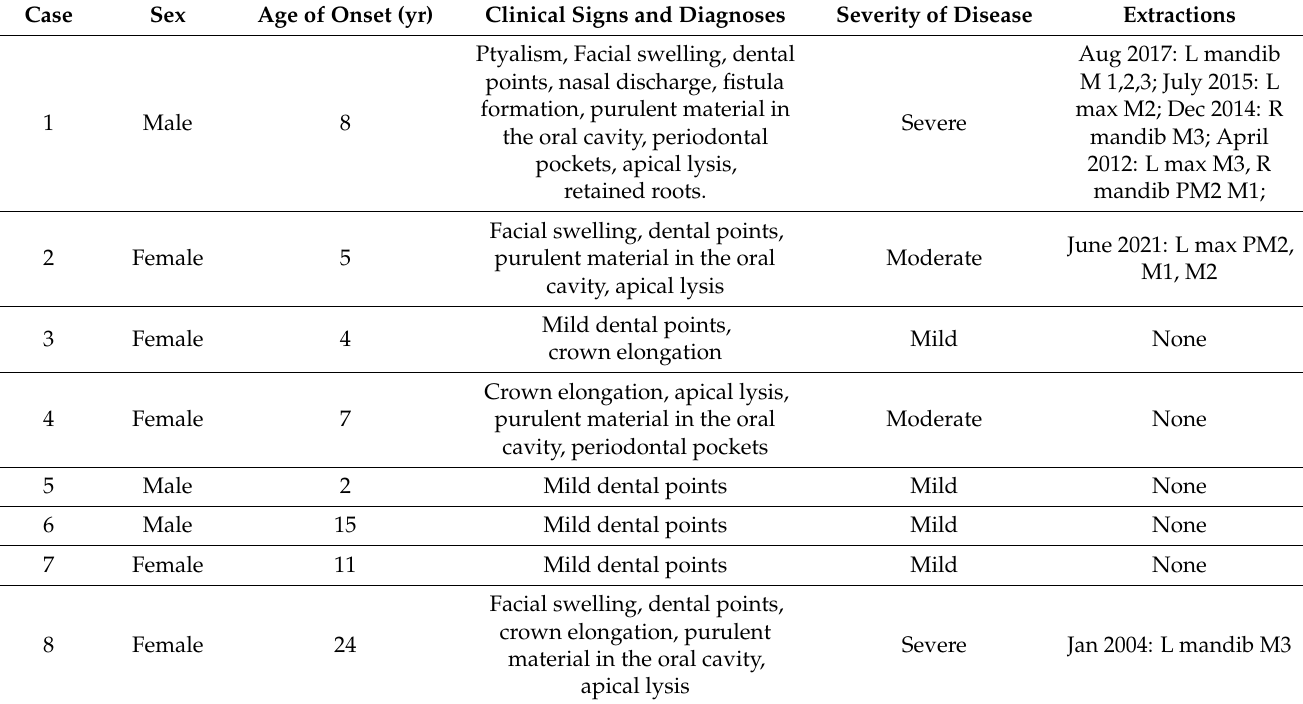
Table 1. Cases of dental disease in aardvarks under managed care at a single zoological institution in the United States, including sex, age of onset of dental disease, clinical and radiographic signs, categorization of the severity of dental disease, and locations of dental extractions (if noted in medical records). Abbreviations used include L (left), R (right), max (maxillary arcade), mandib (mandibular arcade), P (premolar), and M (molar). The subsequent number after P or M designates the number of the corresponding